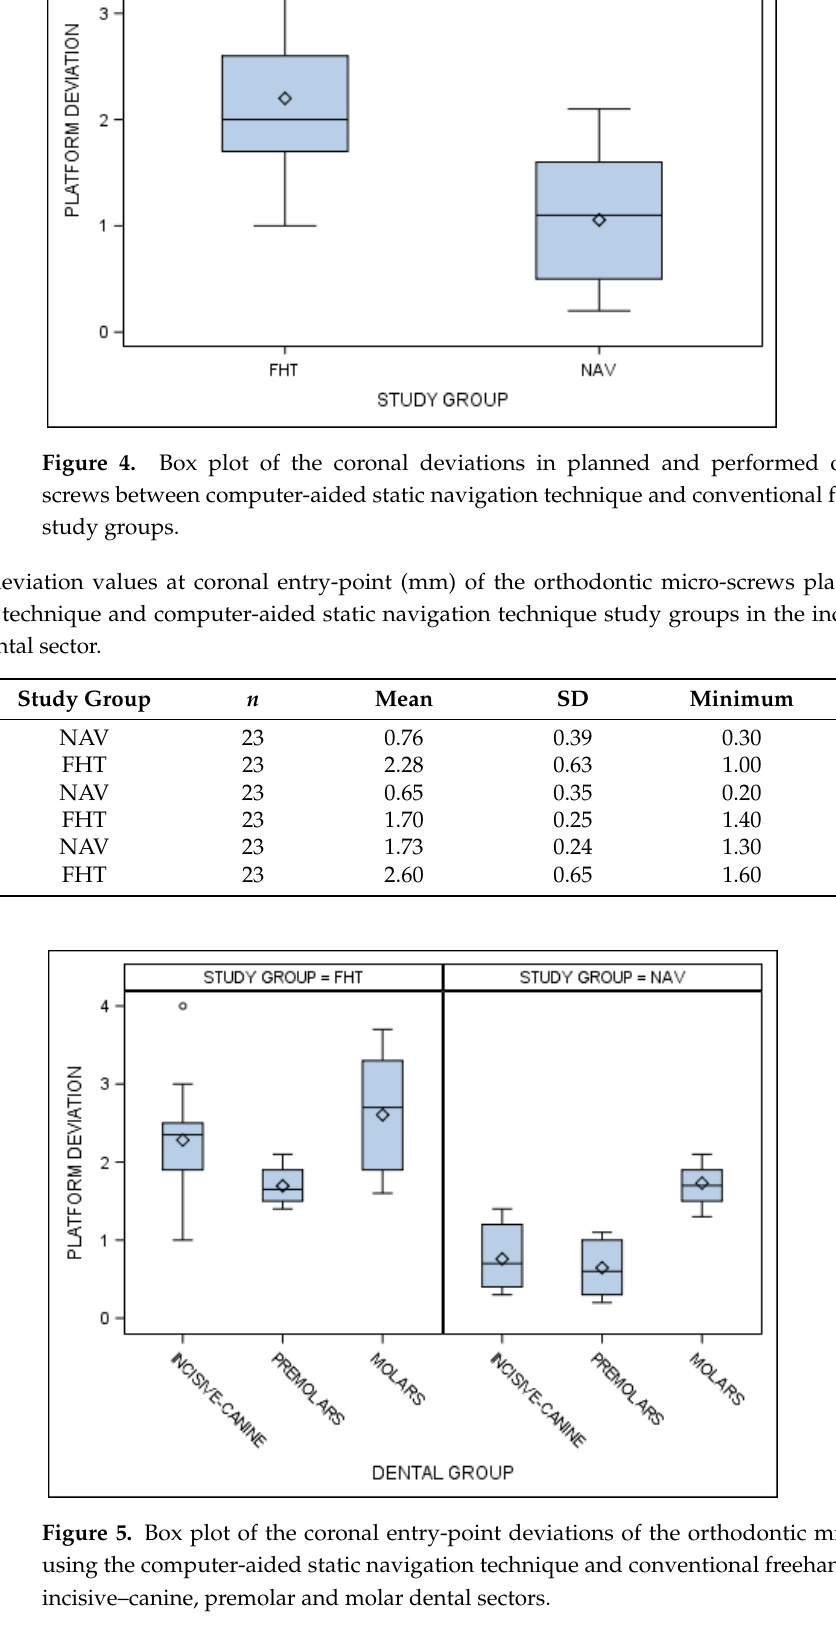
Table 3. Descriptive deviation values at coronal entry-point (mm) of the orthodontic micro-screws placed in the selected tooth positioning. Tooth Location